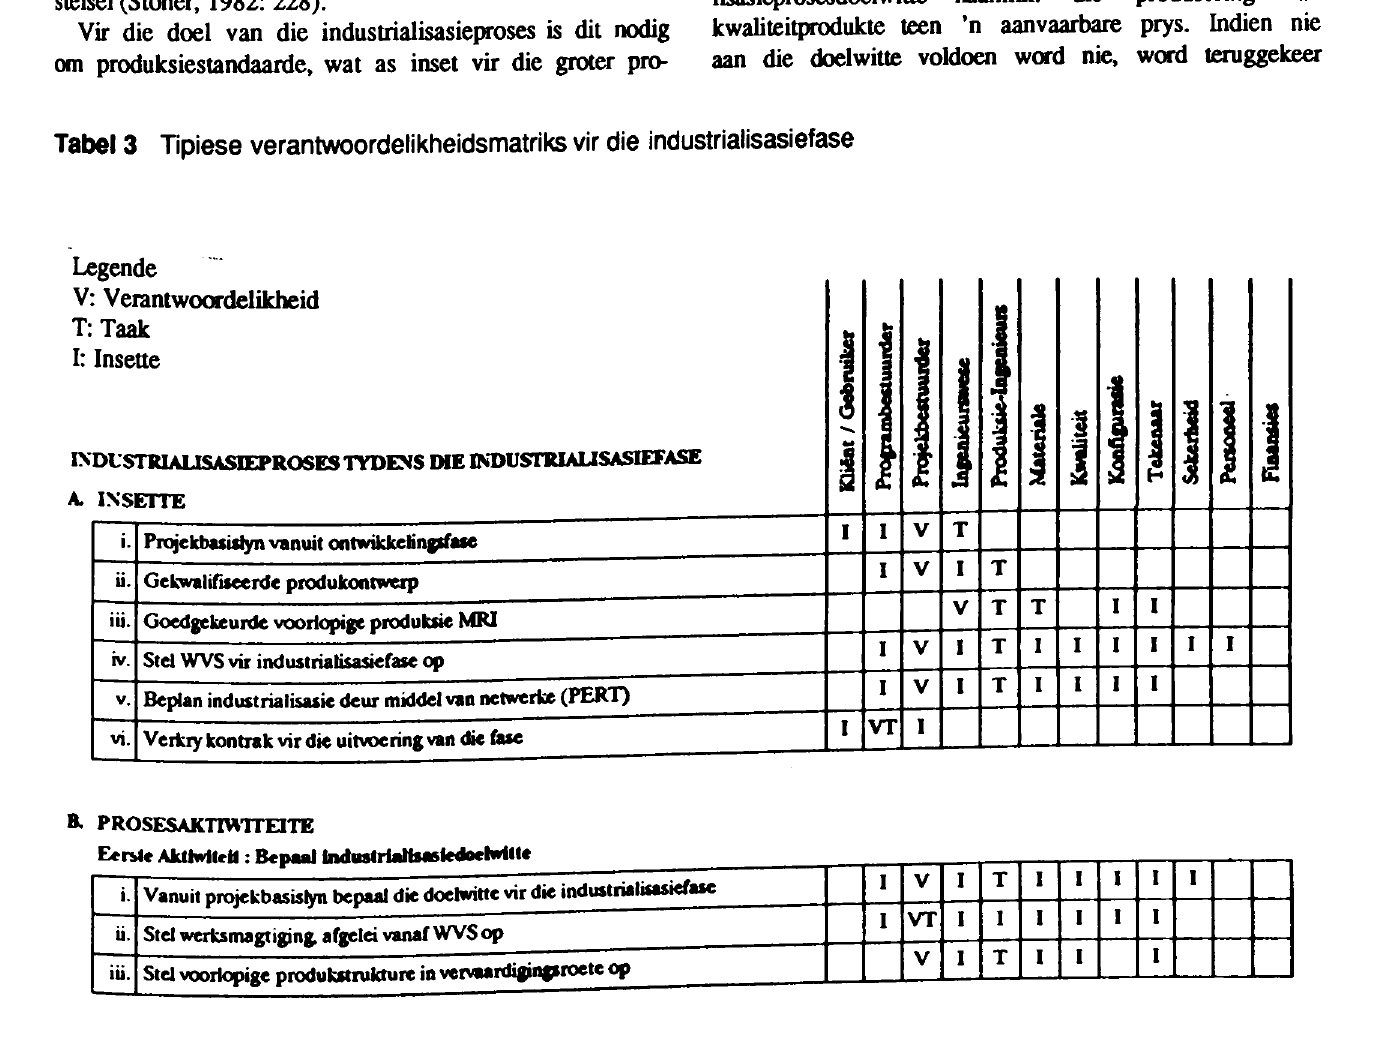
Tabel 3 Tipiese verantwoordelikheidsmatriks vir die industrialisasiefase